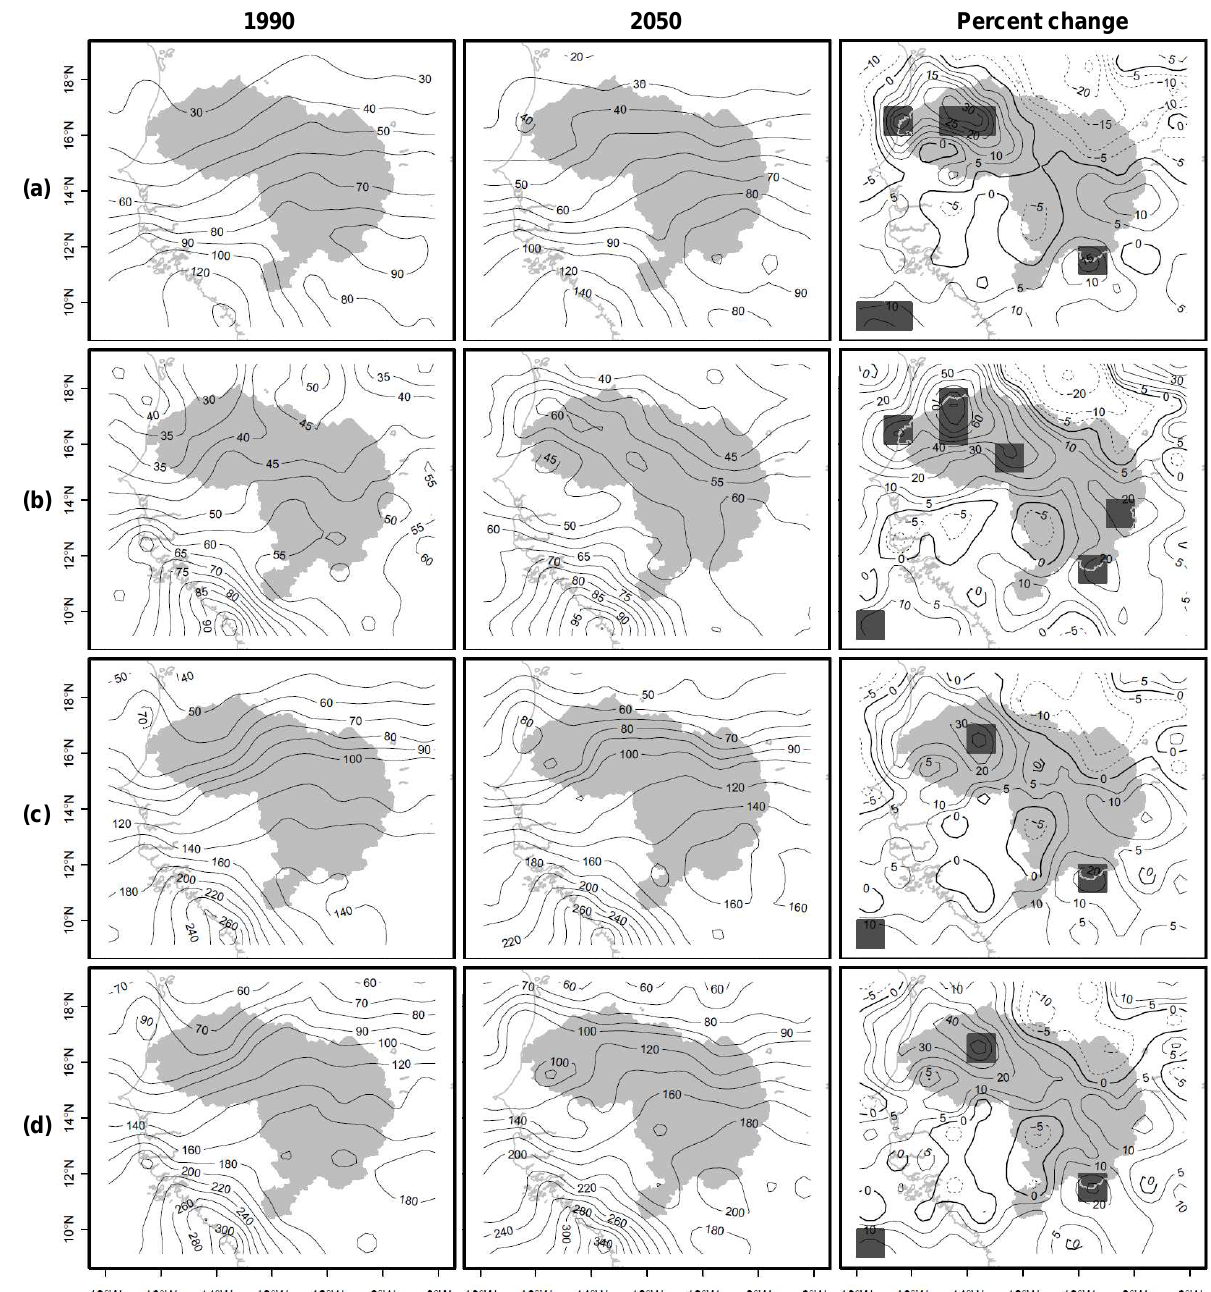
Fig. 5. Interpolated maps from the GAMLSS analysis for each site: (a) mean σ , (b) standard deviation σ ; (c) associated with Tr =10yr, and (d) Tr =20yr. The maps for the years 1990 and 2050, and the percentage difference between them, are presented. In the difference maps, negative values are dashed, while the 95% confidence in projected changes is highlighted with the dark gray